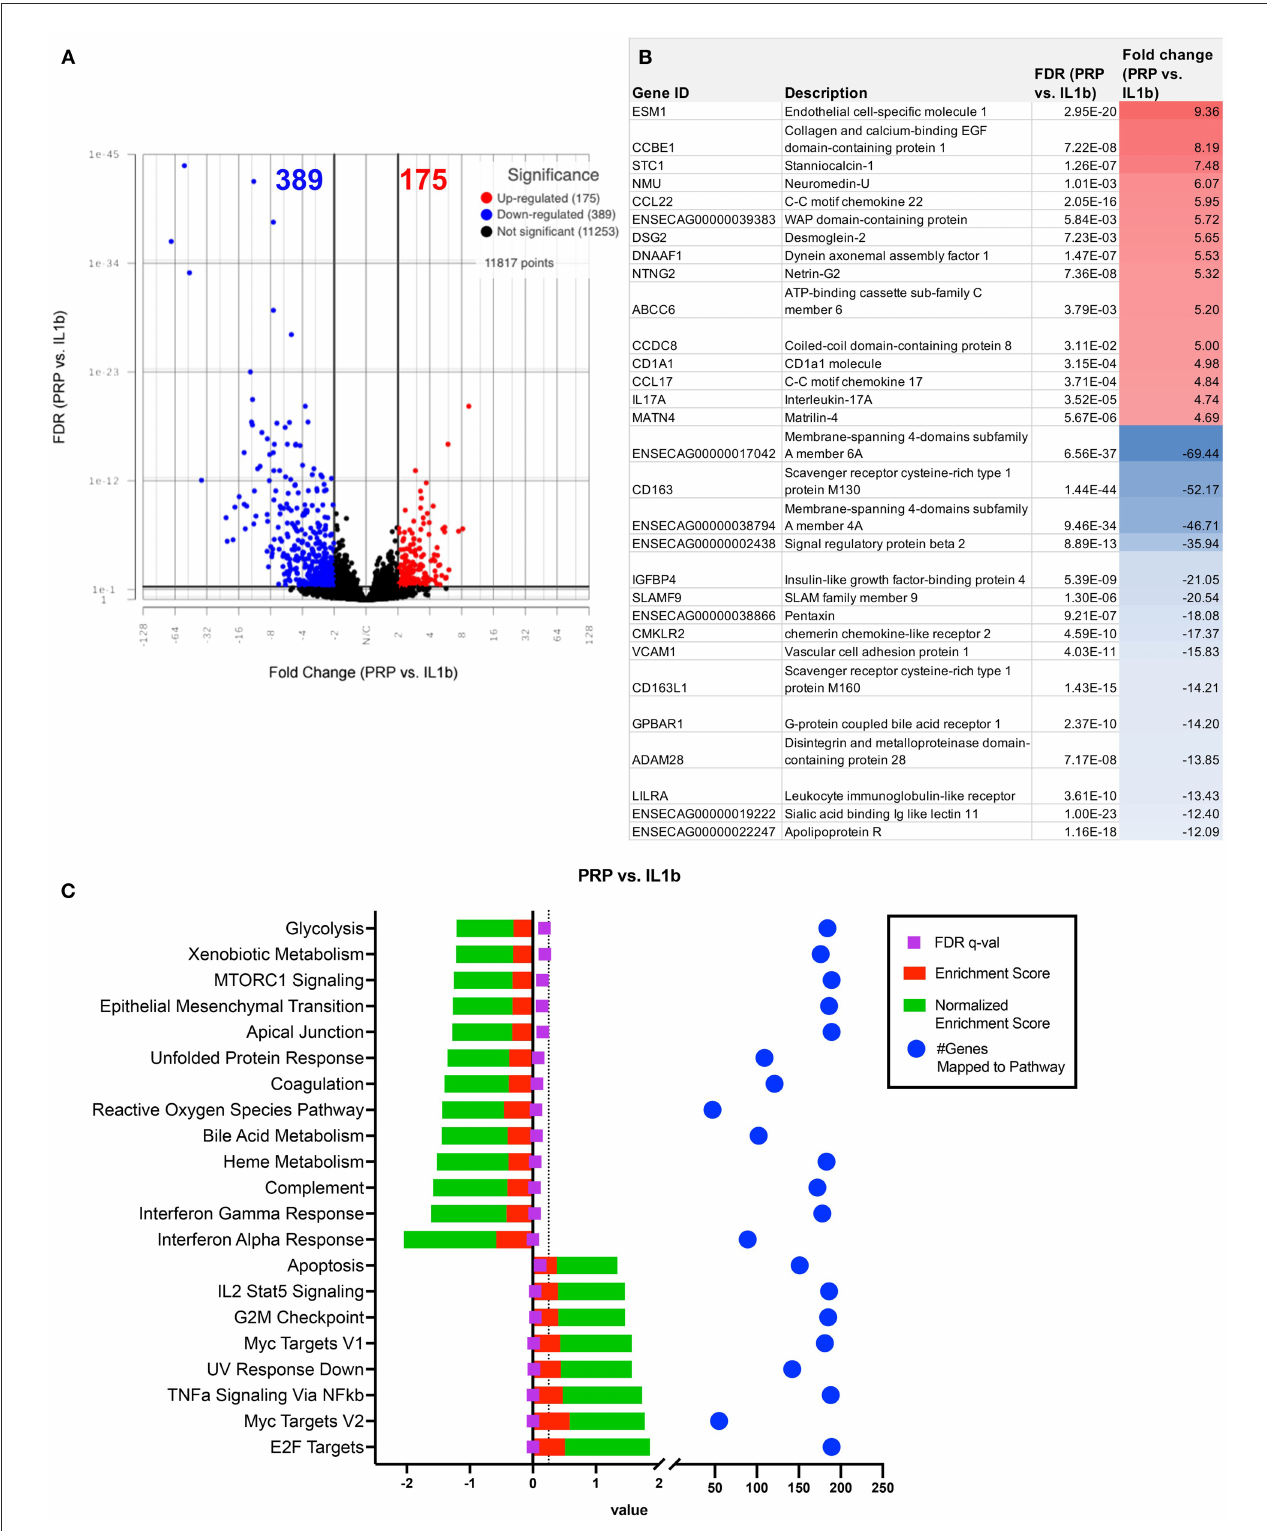
FIGURE6 Differential gene expression and pathway analysis of PRP treated macrophages compared to IL-1ß stimulated. (A) Volcano plot of PRP treated vs. IL-1ß. X-axis shows fold change and y-axis shows unadjusted adjusted p -value. Significance defined as FDR adjusted p -value ≤ 0.05 fold change ≥ 2 or ≤ − 2. (B) List of genes, description, FDR, and fold change of top 15 upregulated and downregulated genes in differential analysis results from PRP treated vs. IL-1ß stimulated samples. (C) GSEA results using normalized counts from n = 3 PRP treated vs. IL-1ß stimulated